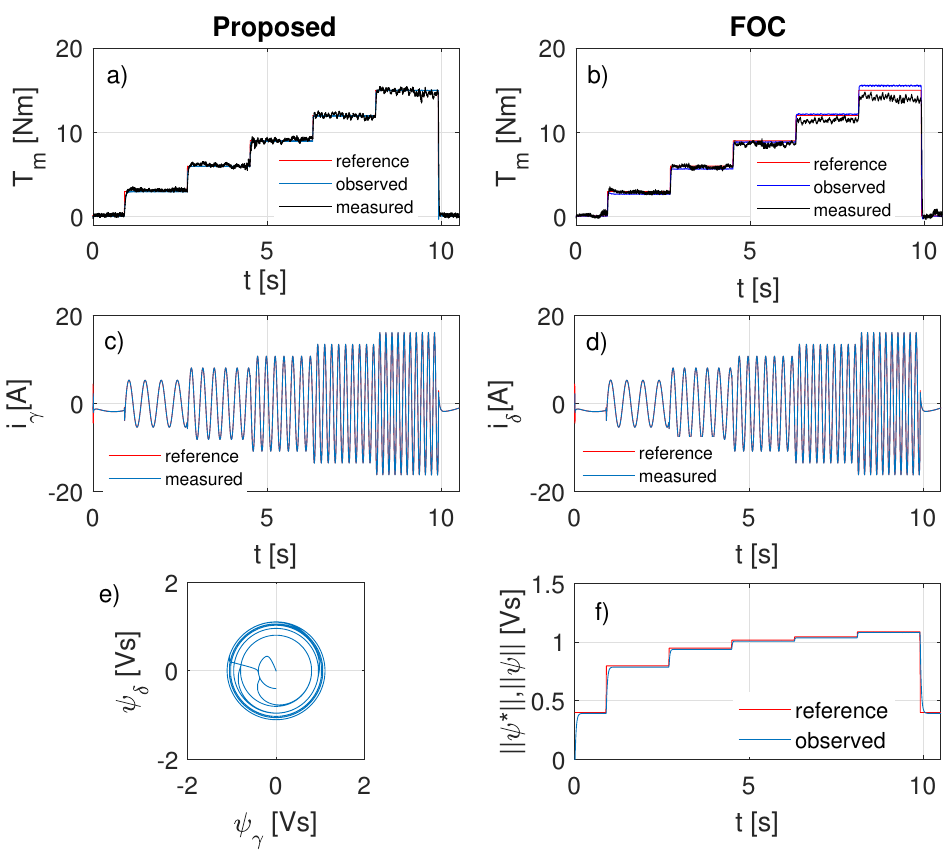
Figure 5. Torque control with adjusted rotor flux magnitude command and piecewise constant torque reference: torque response for proposed method ( a ), torque response for FOC ( b ), stator current components gamma and delta ( c , d ), rotor flux vector trajectory ( e ), rotor flux vector magnitude ( f